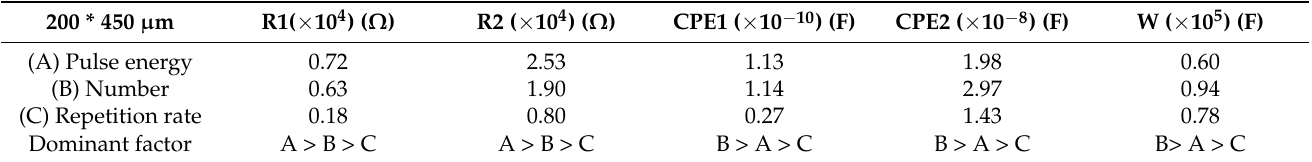
Table 9. The range analysis data for 200 * 450 µ m rectangular template from the key components of equivalent circuit model.